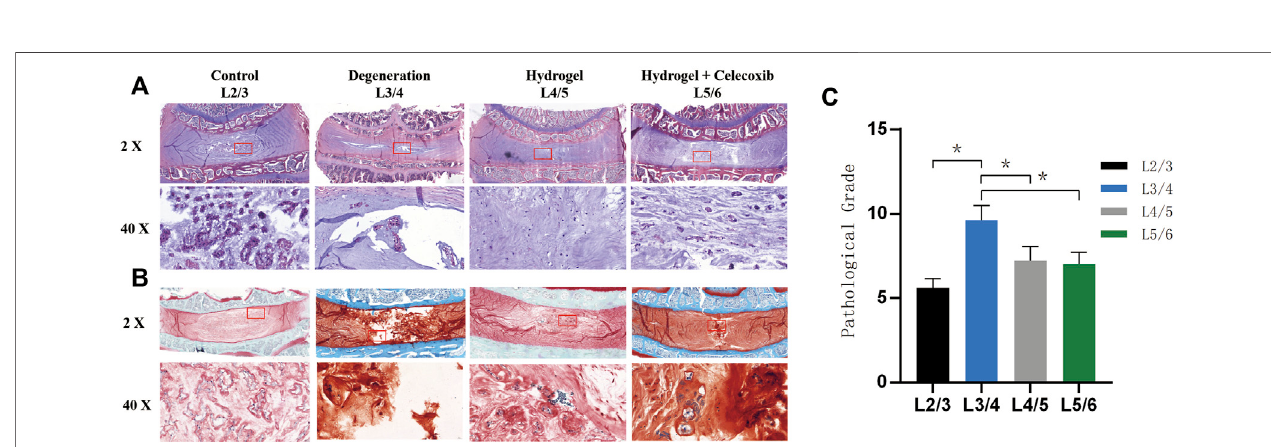
FIGURE8| Morphologicalstaining invivo . (A) Therepresentativeparaf fi nsectionswithH&E. (B) Therepresentativeparaf fi nsectionswithH&E. (C) Thehistological grades of different groups after the operation (*,# = p < 0.05).